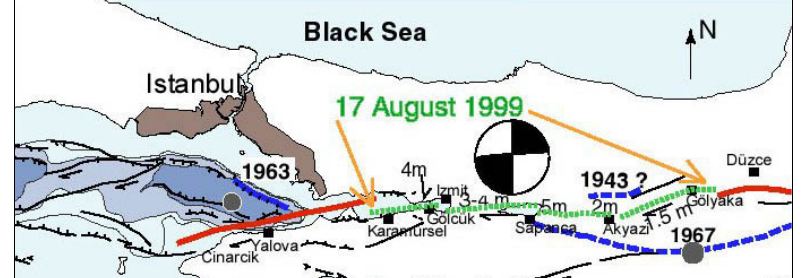
Fig. 1. The map shows the extent of the 1999 rupture (dotted green lines) and the 1943, 1967 and 1963 ruptures (blue lines) and the segments that increased stress (red lines) (Barka, 1999). Fig. 2. Surface rupture of the 12 November D¨uzce earthquake, about 30km, in the green rectangular (KOERI, 2000).